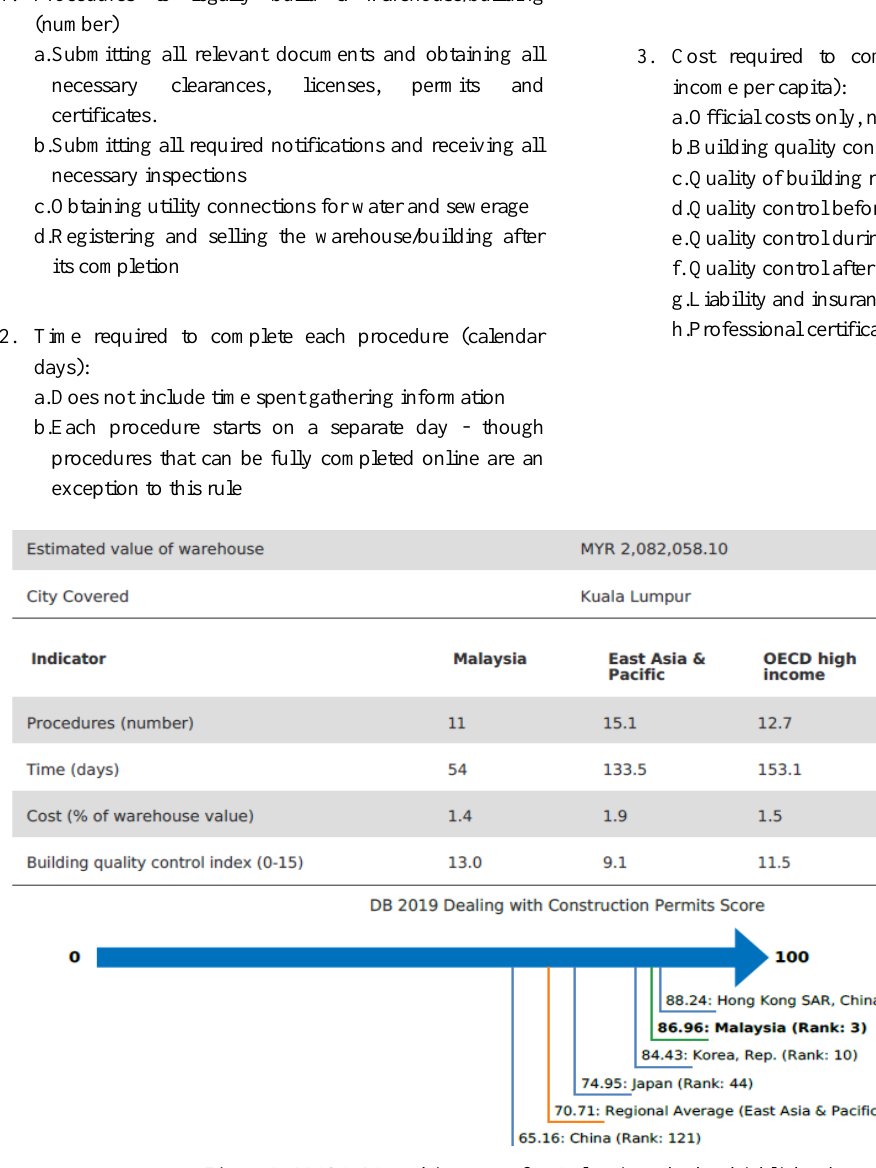
Figure 5: 2018 DCP ranking score for Malaysia and other highlighted countries.